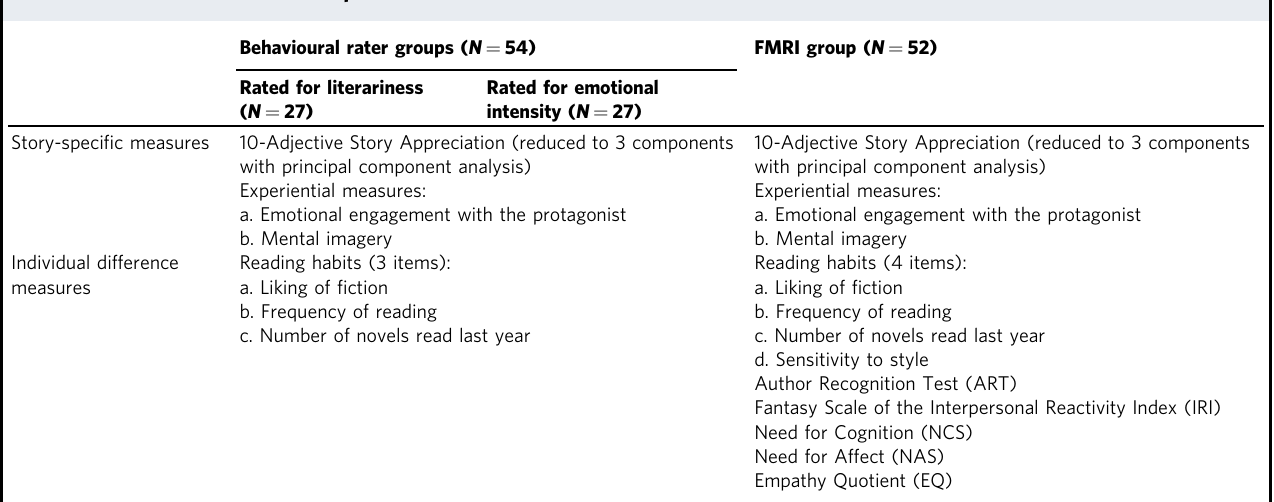
Fig. 4 Principal component analysis on ten-item story appreciation measures from the behavioural rater group ( N = 54). Two items ( “ emotional ” and “ sad ” ) were excluded due to data collection errors. The remaining eight items resulted in three rotated components (RC) with one linked to interest in the story (RC 1 “ interesting ” ), one linked to ease of understanding and accessibility (RC 2 “ accessible ” ), and one component linked to quality of writing (RC3 “ well-written ” ). Table 2 Overview of behavioural